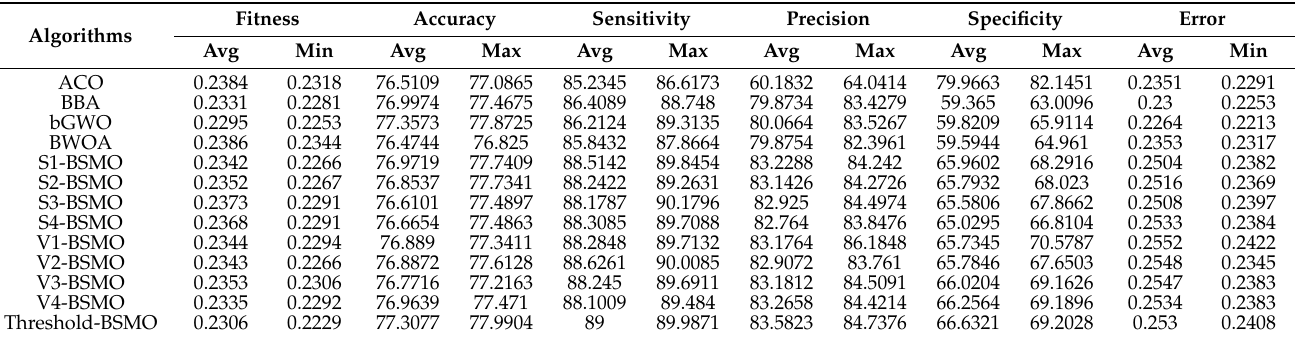
Table 3. Diabetes disease detection.